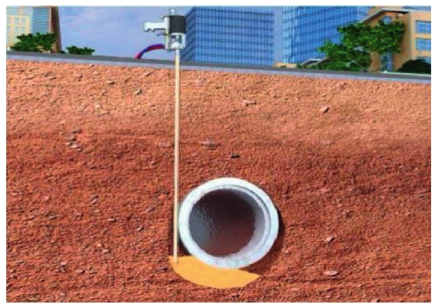
Figure 1: Polymer grouting fills the void outside the pipe.